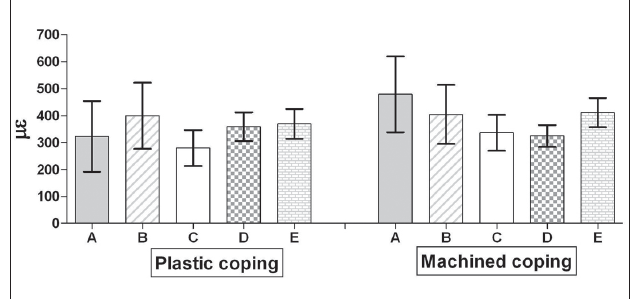
Fig. 5 - Mean values and standard deviations of the microstrain (µ ε ) for plastic and machined copings in each load